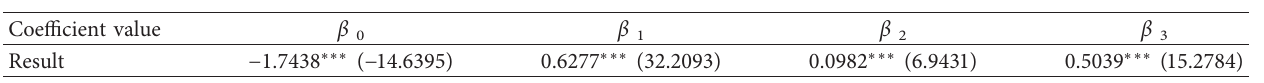
Table 2: Test results.